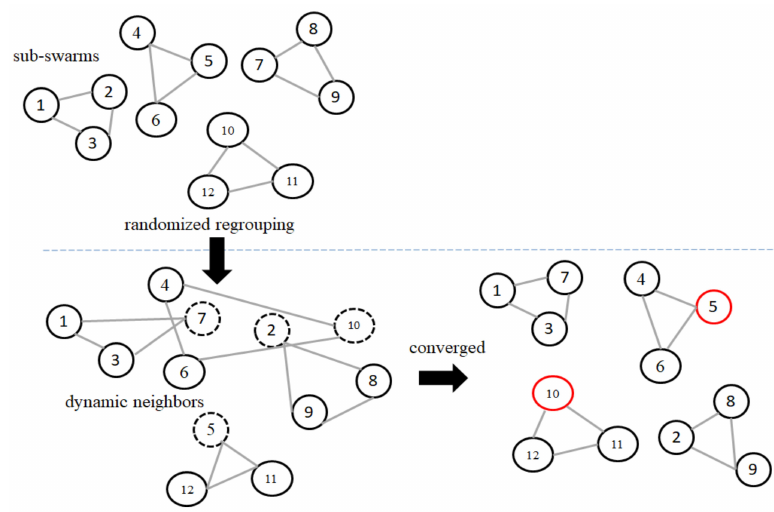
Figure 9. Dynamic regrouping for four particle